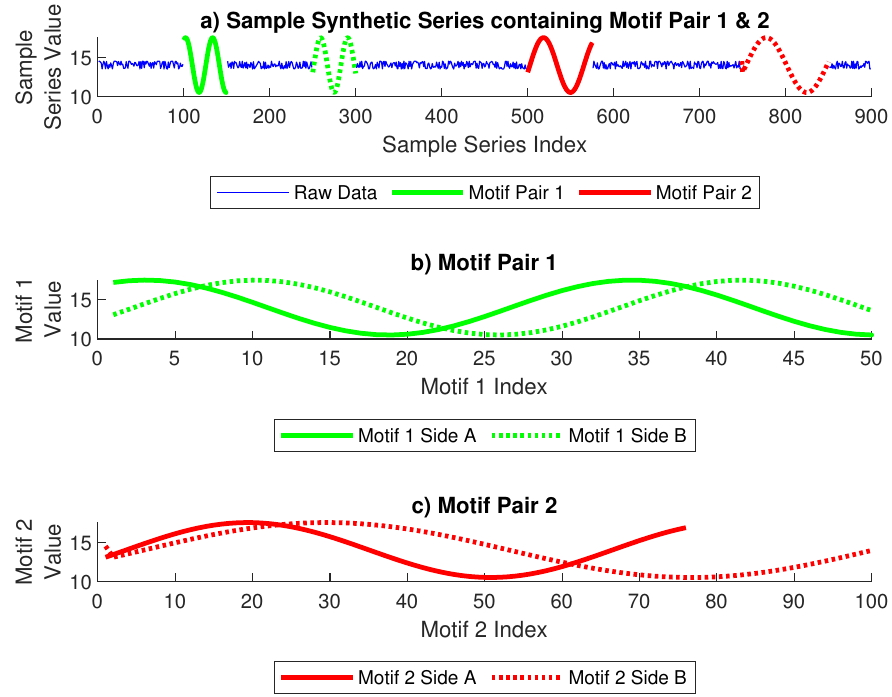
Figure 2. Sample synthetic time series showing two motif pair locations ( a ). Motif Pair 1 ( b ), has equal length for Sides A and B, while Motif Pair 2 ( c ) has differing motif side